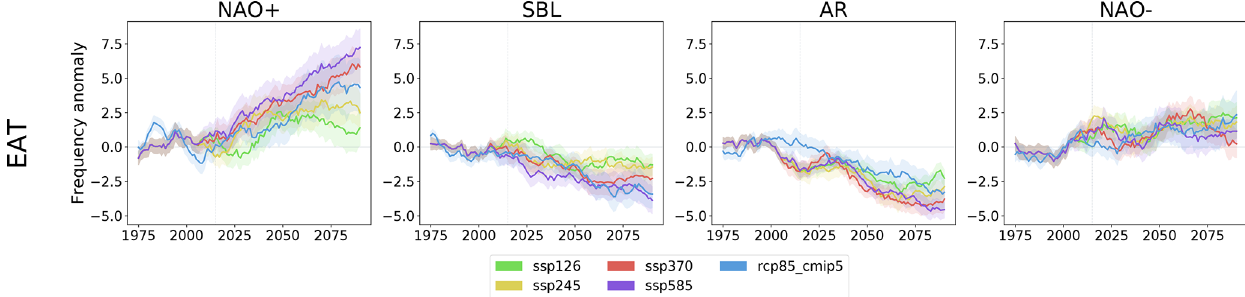
Figure 5. Ensemble means of the WR seasonal frequency anomalies for the CMIP6 scenarios and the CMIP5 RCP8.5 with respect to the historical regime frequency. A 20-year running mean has been applied to the time series. Shading indicates the standard error of each ensemble. A corresponding figure for the PAC sector is Fig.